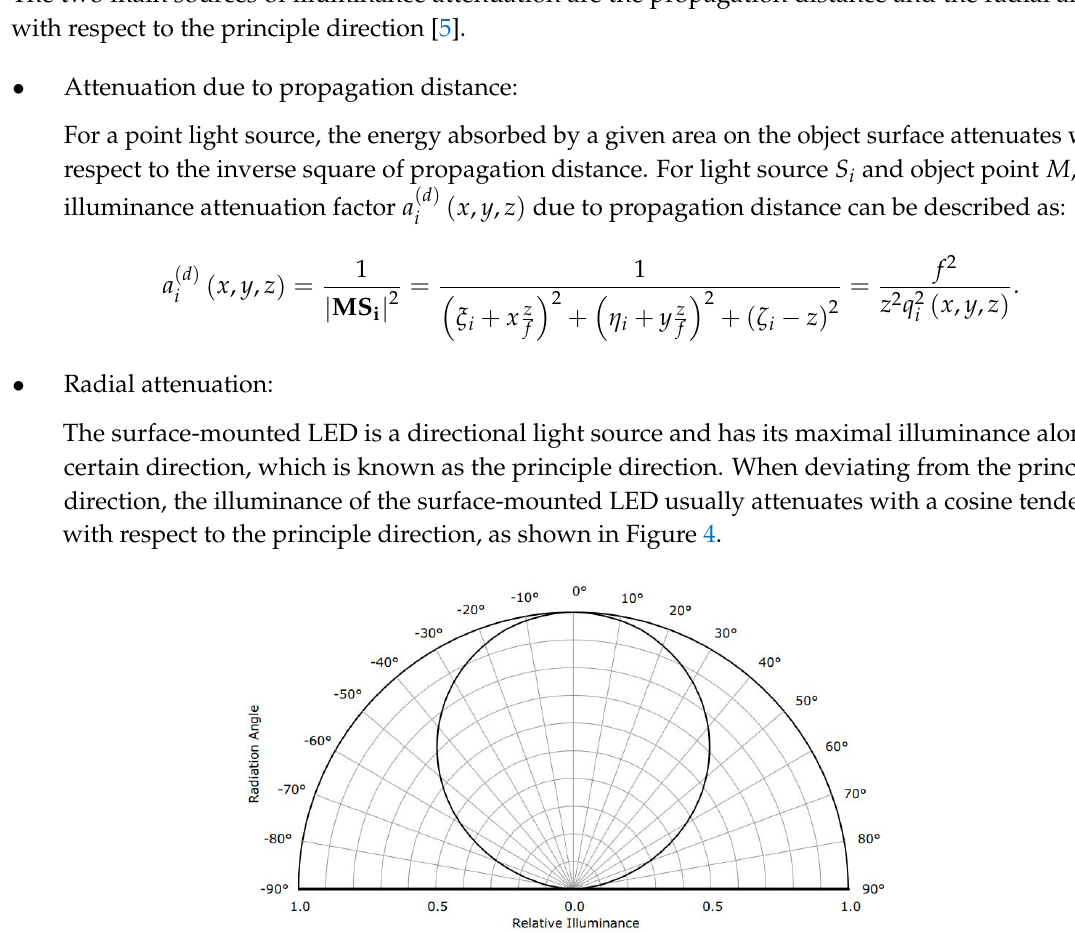
Figure 4. Radial attenuation of the surface-mounted LED with respect to the principle